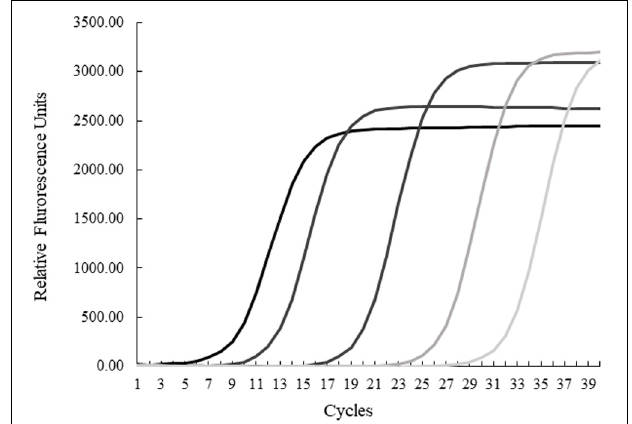
FIGURE 1 | Quantitative PCR results for serial dilutions of Helicobacter enhydrae genomic DNA. Amplification plots from left to right were